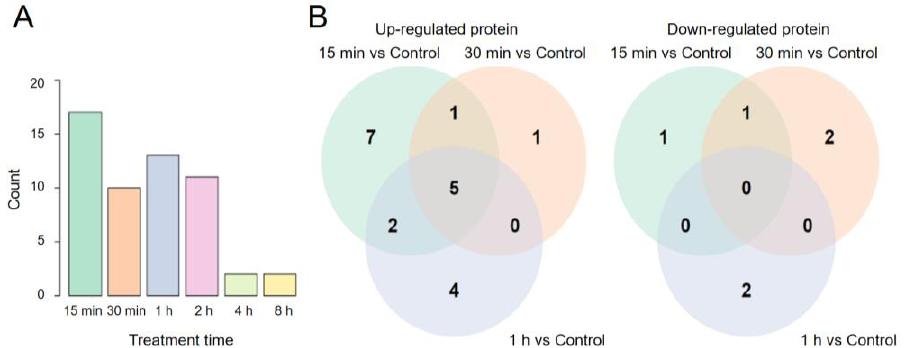
Figure 2. The total number of RPPA events affected by S µ G in human fibroblasts ( A ) and Venn diagram showing numbers of early response proteins in cells exposed to S µ G for 15 min, 30 min, and 1 h ( B ). The statistically significant proteins were identified by pair-wise comparisons between treated cells and control cells using LIMMA. FDR of < 0.05 was used as the significant level.